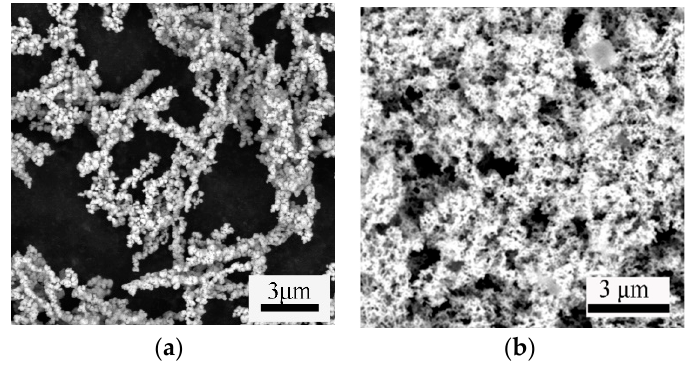
Figure 6. SEM images of nNi ( a ) and HTPB/nNi ( b ).